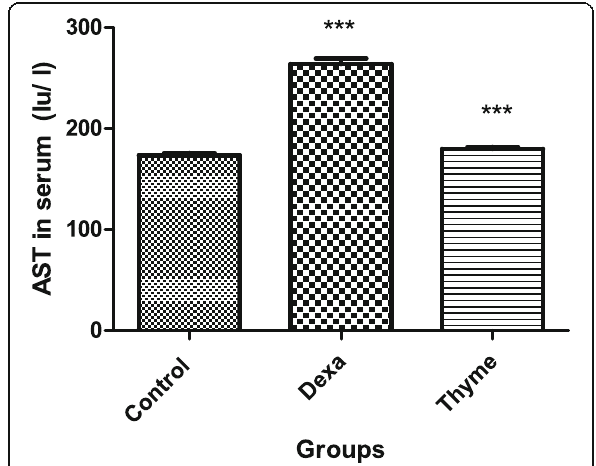
Fig. 4 The defensive role of thyme aqueous extract on serum lactate dehydrogenase (LDH) activity in normal and dexamethasone (DXM)-treated rats. Percentage changes (%) were calculated by comparing normal group with DXM-treated group and pre-treated DXM groups with DXM-treated